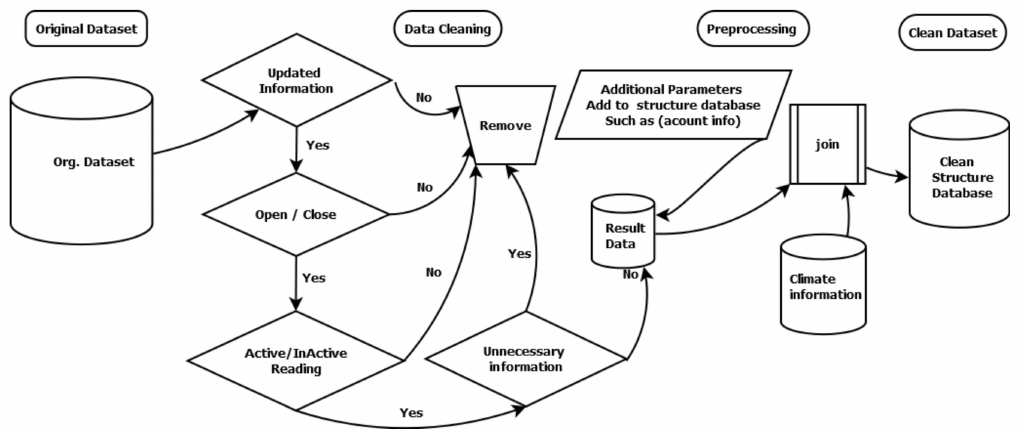
Figure 4. Data Cleaning and Pre-processing.